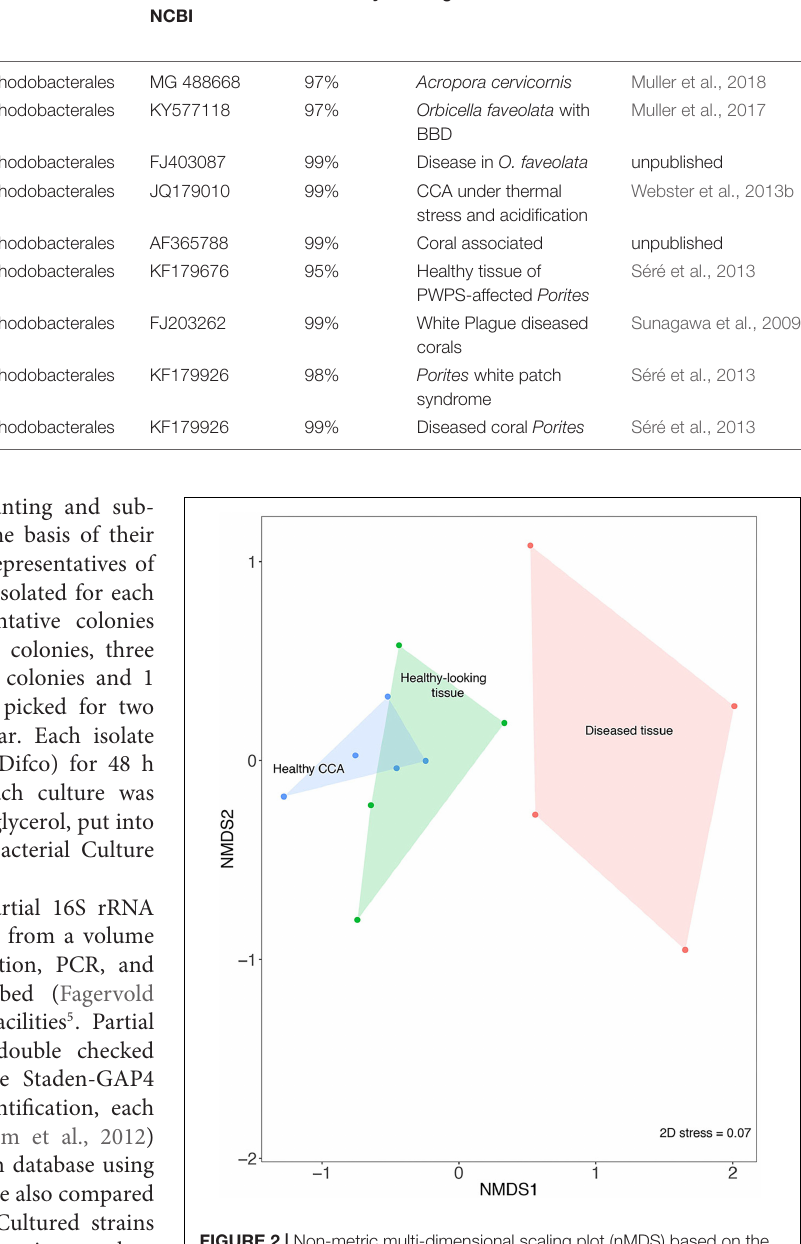
FIGURE 2 | Non-metric multi-dimensional scaling plot (nMDS) based on the Bray–Curtis similarity index showing the similarity between bacterial community composition from healthy and diseased tissues in CCA affected by